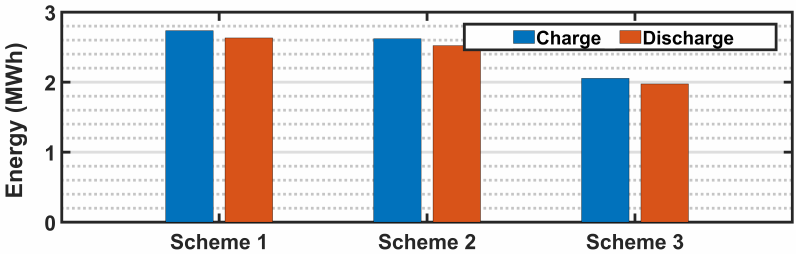
Figure 19. Annual accumulative charge and discharge energy for EV storage.